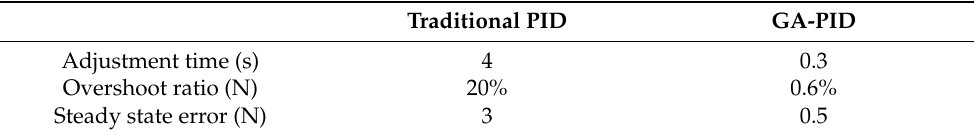
Table 4. Simulation data of propulsive force under the single coal hardness.